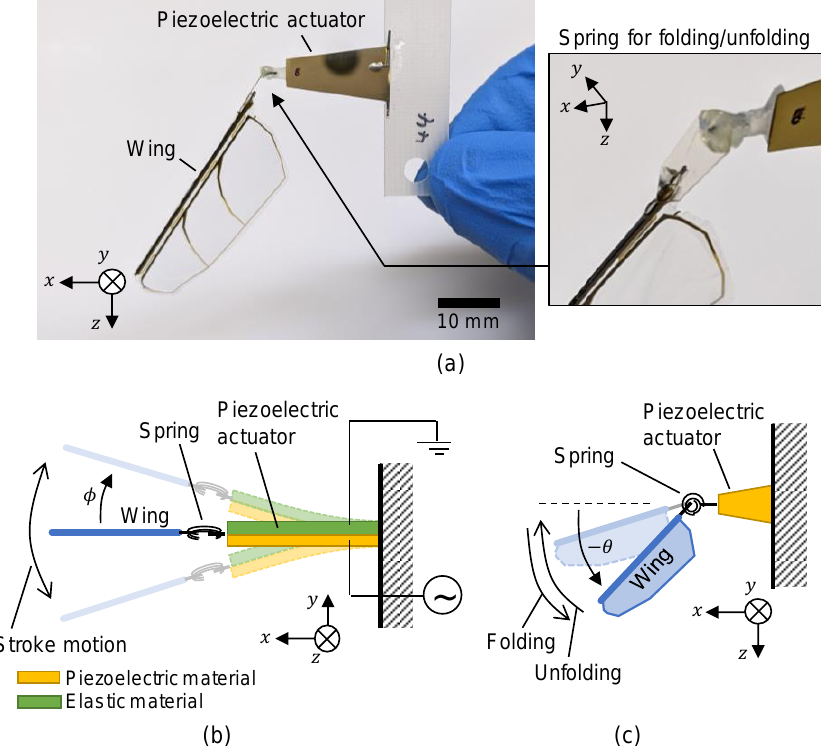
Figure 1. Structureoftheflapping-wingactuatorwithpassivefolding / unfoldingmechanism: ( a )photograph Figure 1. Structure of the flapping-wing actuator with passive folding/unfolding mechanism: ( a ) of the actuator and spring for folding / unfolding; ( b ) stroke motion and ( c ) folding / unfolding photograph of the actuator and spring for folding/unfolding; ( b ) stroke motion and ( c ) folding/unfolding motion.